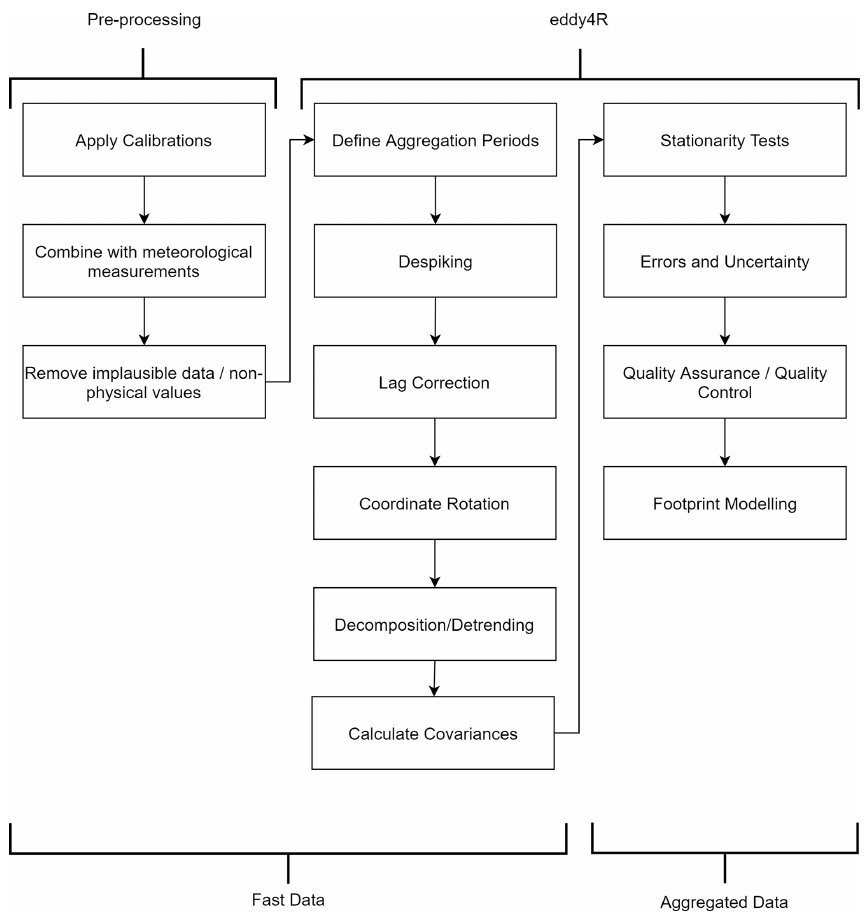
Figure A1. Schematic eddy covariance calculation workflow.